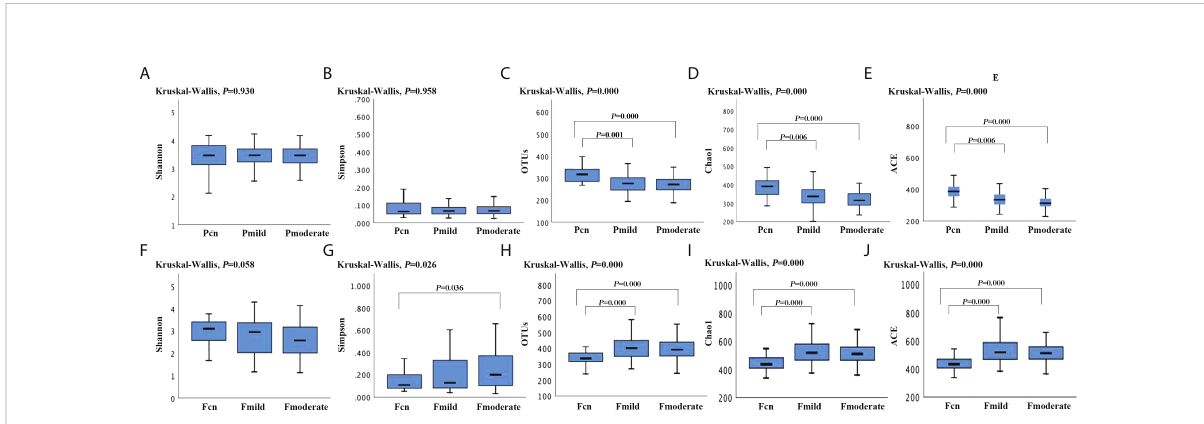
FIGURE 1 The a -diversity analysis (Shannon, Simpson, the observed OTUs, ACE, Chao-1 index) of the oral and gut microbiotas among the three groups. The oral a -diversity analysis (A – E) and the gut a -diversity analysis (F – J) are presented. p -values calculated using Kruskal – Wallis-test among three groups, and post hoc group comparisons evaluated by Bonferroni adjustment. Pcn, subgingival plaque of normal cognition controls; Fcn, feces of normal cognition controls; Pmild, subgingival plaque of mild AD; Fmild, feces of mild AD; Pmoderate, subgingival plaque of moderate AD; Fmoderate, feces of moderate